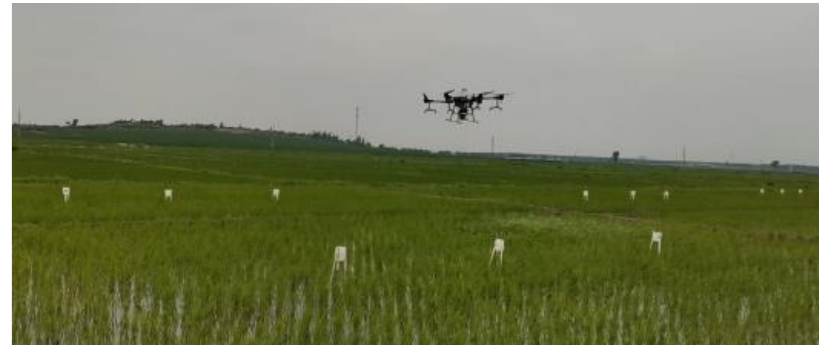
Figure 7. Fertilizer granule collection method.